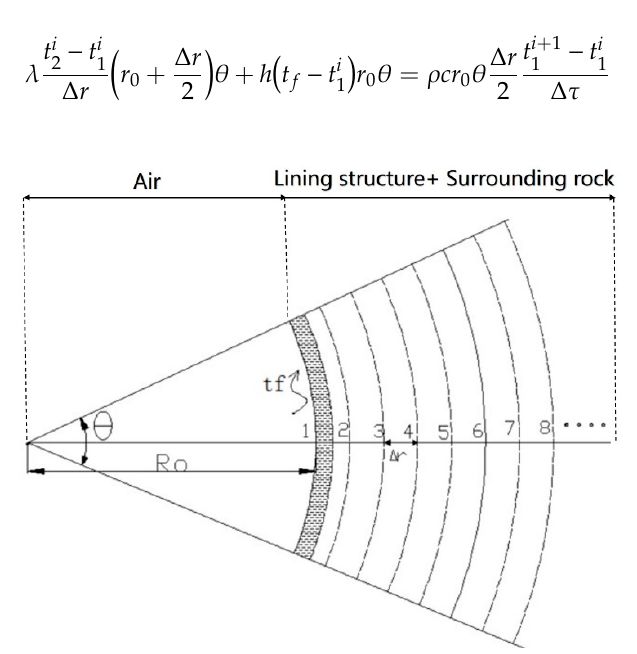
Figure 2. Convective heat transfer boundary node.